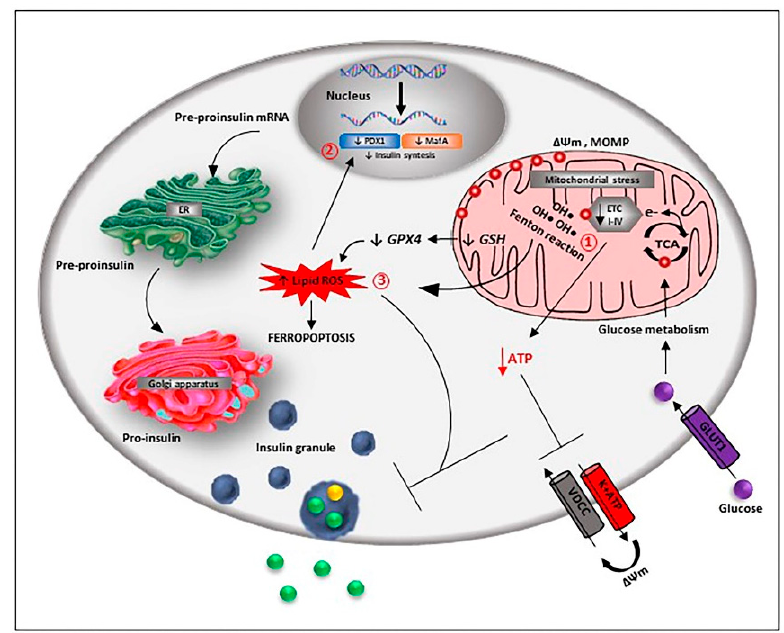
Figure 3. Iron-mediated toxic effects in beta-cells. Iron-mediated beta-cell toxicity is mainly due to reactive oxygen species (ROS) accumulation through Fenton’s reaction. ROS excess determines DNA, lipid and protein oxidation that causes mitochondrial damage, leading to insulin release and apoptosis (1). ROS also influence the activity of the pancreatic and duodenal homeobox 1 (PDX1) and V-Maf avian musculoaponeurotic fibrosarcoma oncogene homolog A (MafA), critical transcription factors for the control of insulin gene expression (2). Iron can induce beta-cell loss also through ferroptosis, a non-apoptotic cell death mechanism characterised by lipid ROS accumulation due to glutathione (GSH) depletion and consequent glutathione peroxidase-4 (GPX4) inhibition (3). The pancreatic and duodenal homeobox 1 (PDX1) and V-Maf avian musculoaponeu- rotic fibrosarcoma oncogene homolog A (MafA), two critical transcription factors